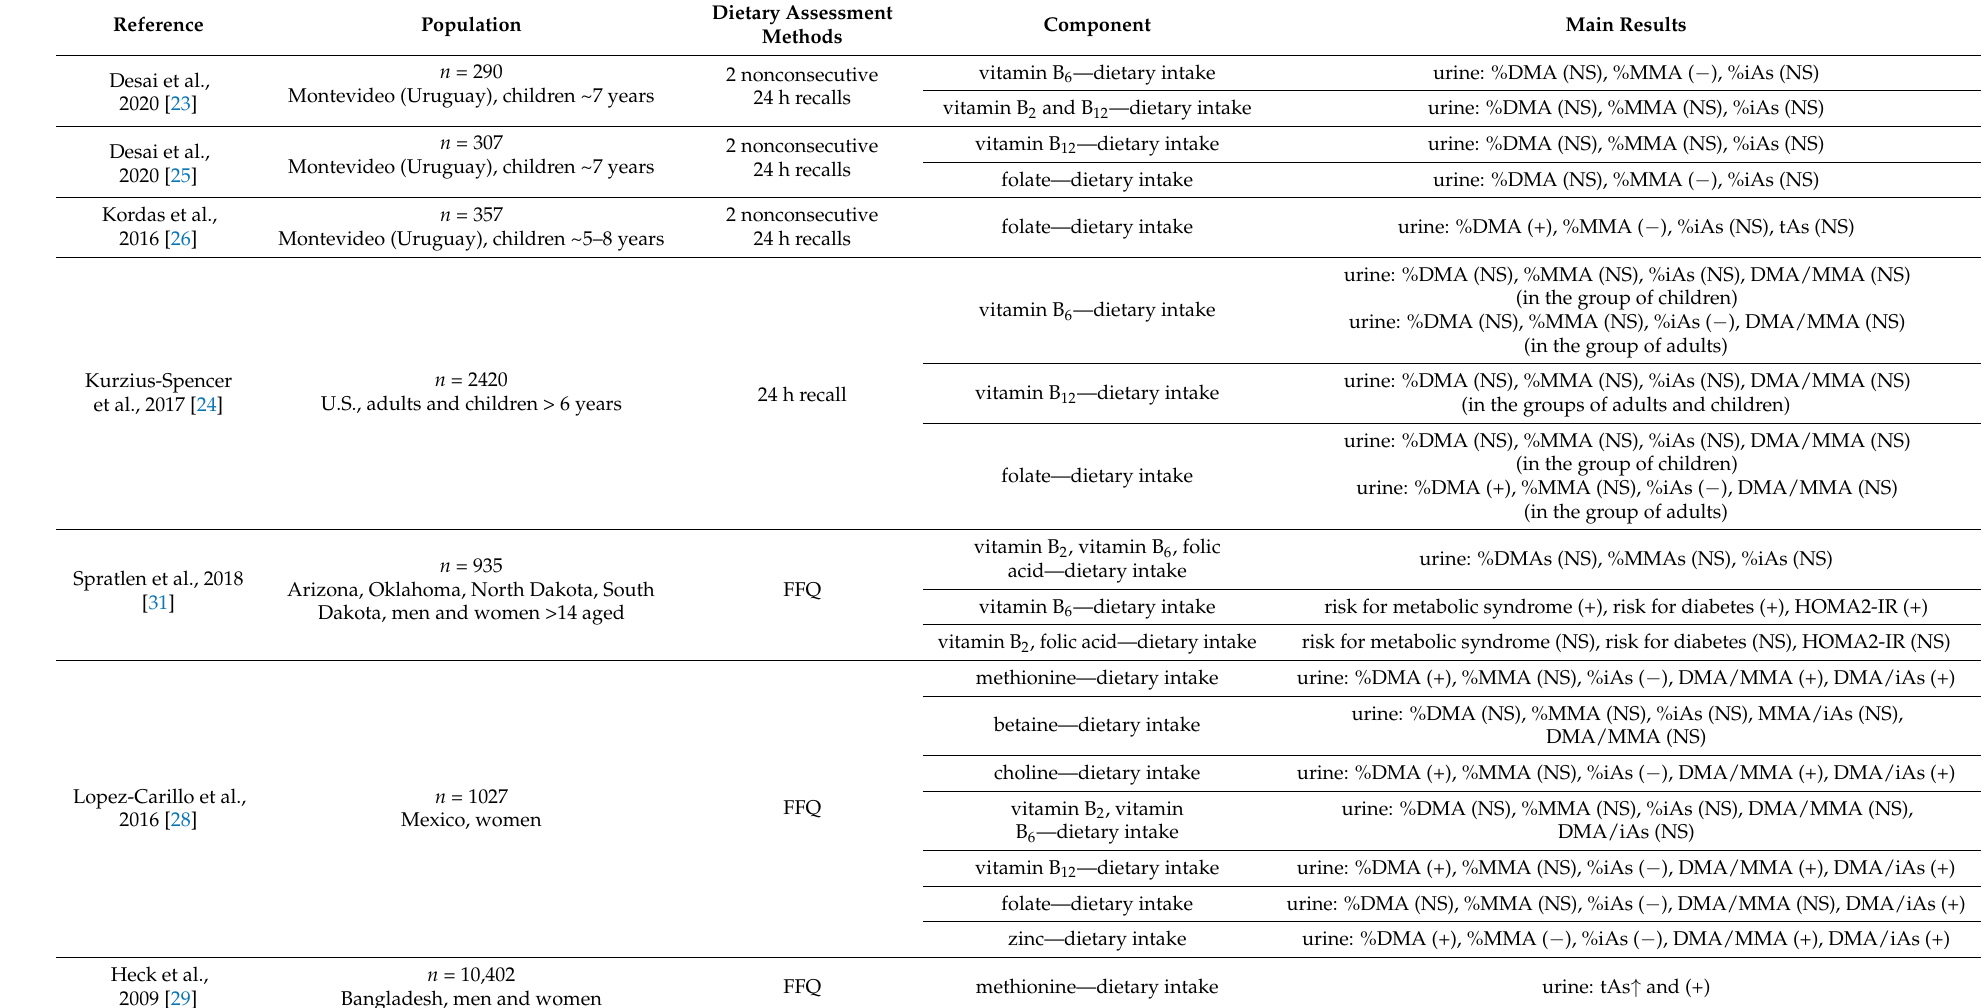
Table 2. Relationship between dietary compound intake and iAs metabolism and health effects related to As